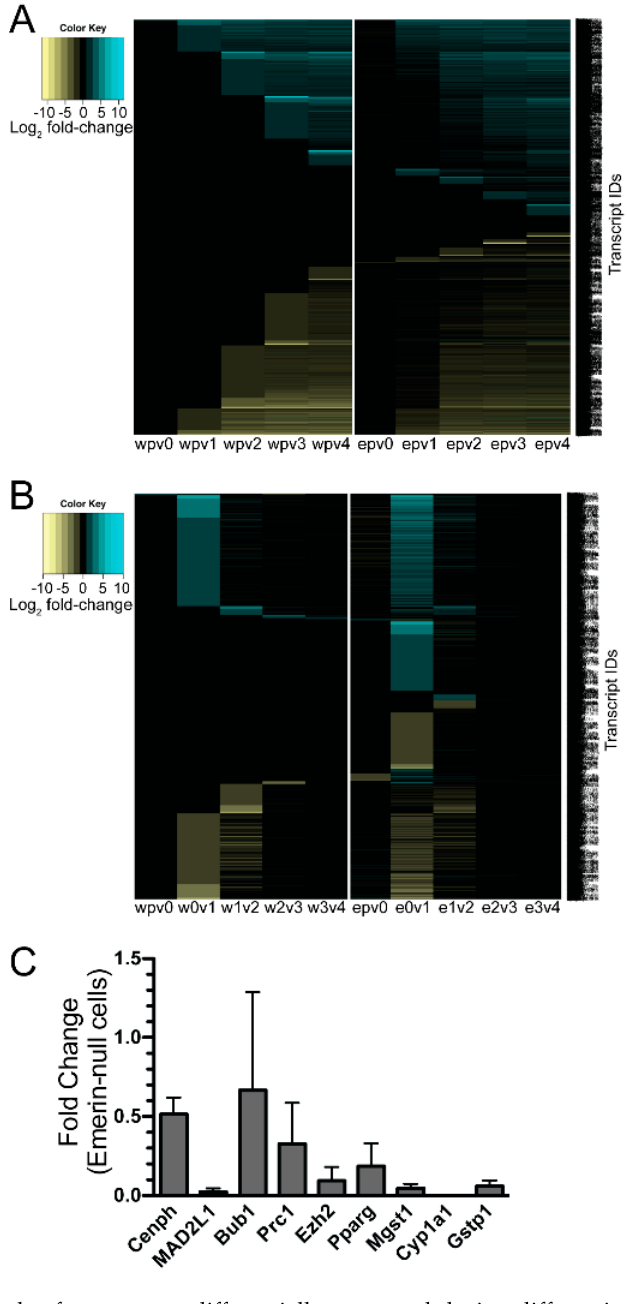
Figure 3. Thousands of genes were differentially expressed during differentiation of emerin-null myogenic progenitors. ( A ) Heat map comparing wildtype and emerin-null cells to one another at each differentiation time point. ( B ) Heat map comparing gene expression changes for each day with the preceding day during differentiation of wildtype (w) or emerin-null (e) myogenic progenitors. Expression changes are Log 2 . Yellow signifies downregulation; Blue signifies activation; e, emerin-null; w, wildtype; v, versus; p, proliferating cells, 0, differentiation day 0; 1, differentiation day 1; 2, differentiation day 2; 3, differentiation day 3; 4, differentiation day 4. The names of the >3000 transcripts are shown on the right. ( C ) qPCR validation of selected genes. RNA was purified from differentiating emerin-null or wildtype myogenic progenitors one day after differentiation induction. Fold change refers to changes in expression in emerin-null cells compared to wildtype cells. Expression of each gene in emerin-null cells was normalized to GAPDH and Oaz1. Data represents mean and SEM.